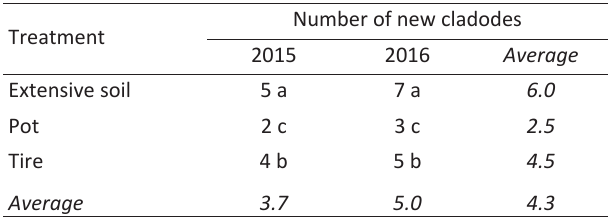
Table 1 - Number of new cladodes in the three treatments in the two years of trial and average